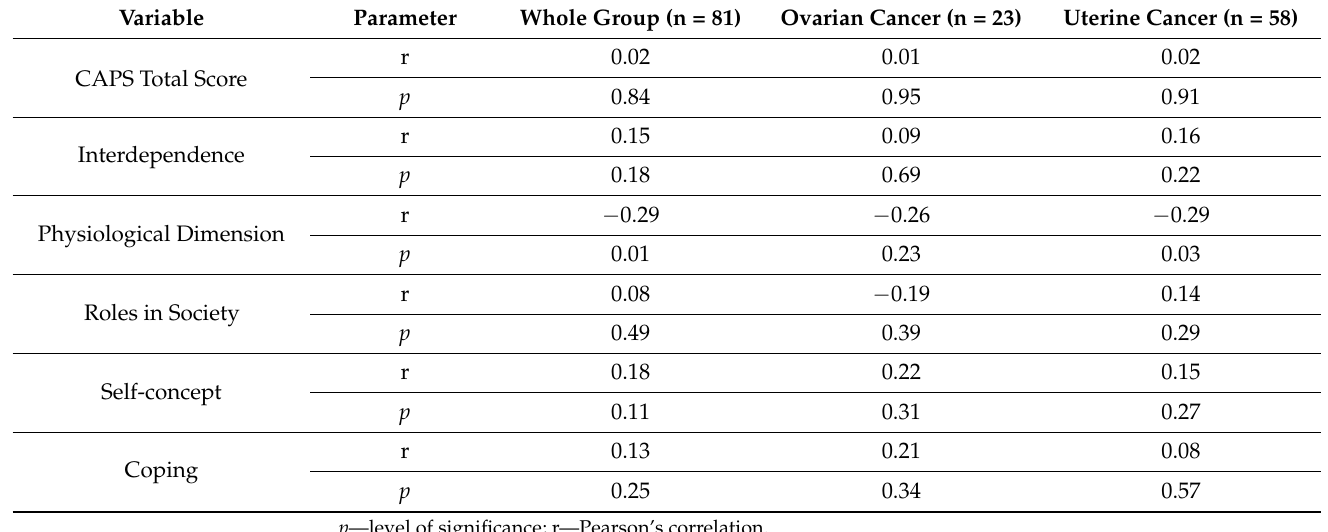
Table 7. Correlations between the AIS and the CAPS scores.